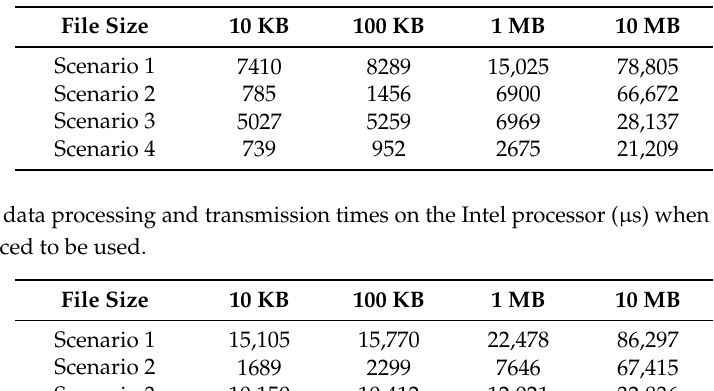
Table 3. Total data processing and transmission times on the Intel processor ( µ s).